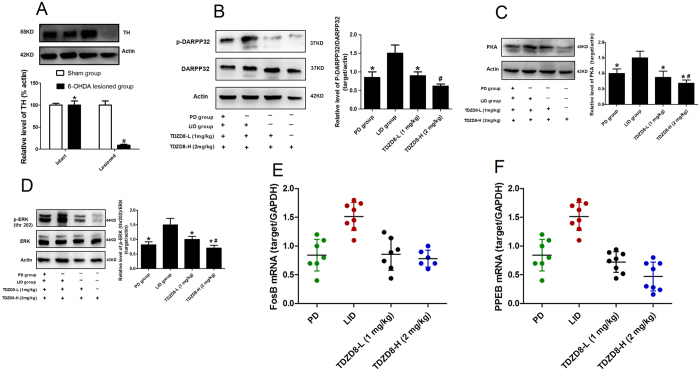
(A–D) Protein levels were evaluated by Western blotting of proteins extracted from the striatum ipsilateral to the 6-OHDA lesion. They were assessed in extracts from 6-OHDA-lesioned rats treated with vehicle, pulsatile L-dopa (25 mg/kg) plus benserazide (6.25 mg/kg), TDZD8-L (1 mg/kg) and TDZD8-H (2 mg/kg). (A) The degree of dopamine depletion induced by 6-OHDA lesions and sham. Tyrosine hydroxylase (TH) levels expressed relative to actin levels. #p < 0.01 and *p > 0.05 vs sham-intact hemisphere (n = 4); (B) phosphorylated DARPP32 level expressed relative to tatal DARPP32 level; (C) PKA level expressed relative to actin levels; (D) phosphorylated ERK1/2 level expressed relative to total ERK1/2 level; (E,F) mRNA expression of FosB and PPEB were evaluated by Q-PCR from the striatum ipsilateral to the 6-OHDA lesion. (E) FosB mRNA level expressed relative to GAPDH mRNA; (F) PPEB mRNA level expressed relative to GAPDH mRNA. *p < 0.05 vs LID group; #p < 0.05 vs TDZD8-L group (one-way ANOVA, n = 4 per group).